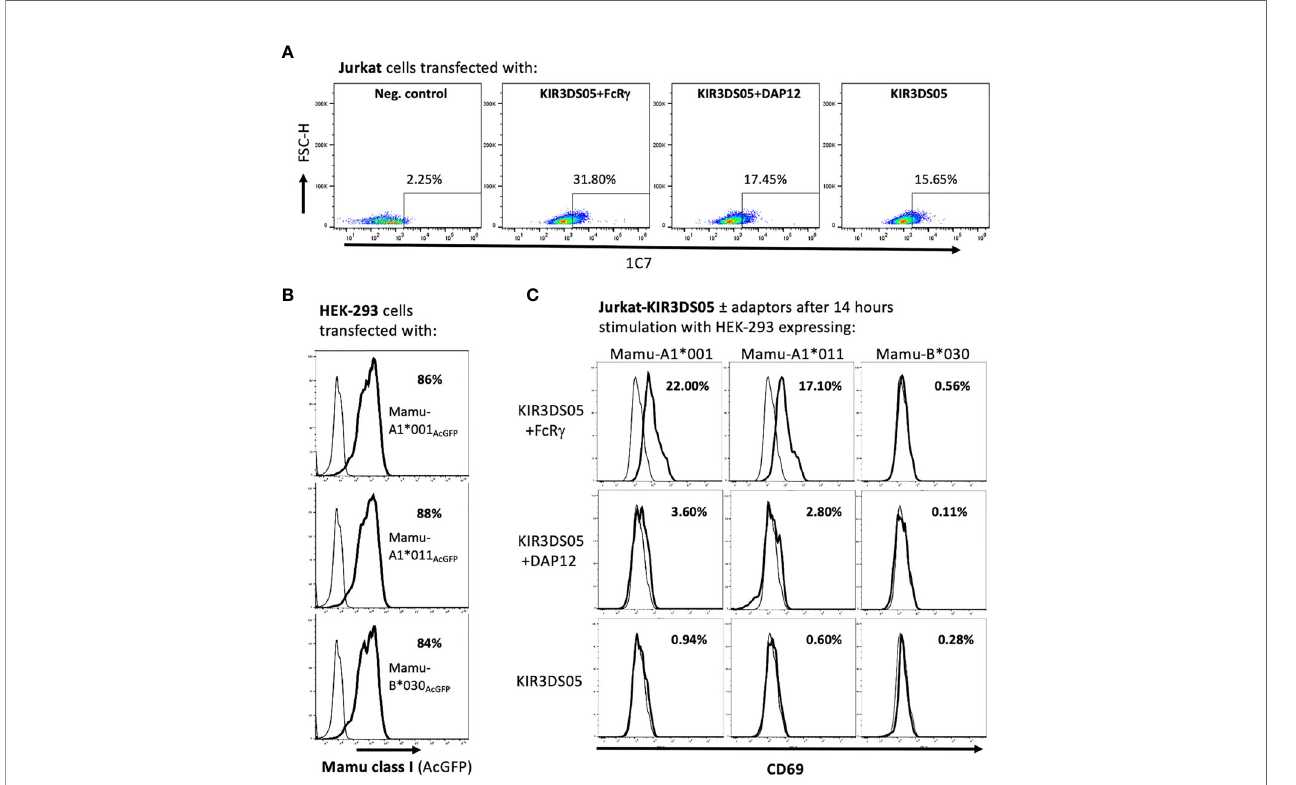
FIGURE 5 | Signal transduction via adaptor protein resulting from interaction of KIR3DS05 with its cognate ligands. Transfected (bold lines) and untransfected control (thin lines) cells are shown. (A) Jurkat cells were transfected with plasmids carrying AcGFP-tagged KIR3DS05 and either myc-tagged DAP12 or FcR g . Cell surface expression of KIR3DS05 was analyzed in FACS using antibody 1C7. (B) Flow cytometric analysis of AcGFP expression in HEK-293 cells stably transfected with constructs encoding AcGFp-tagged versions of Mamu class I that were described previously (25, 27). (C) The transfected Jurkat cells were incubated for 14 h